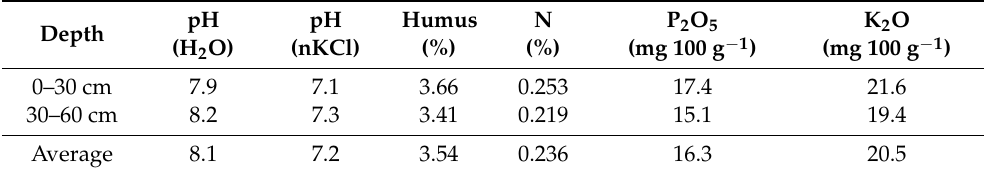
Table 3. Agrochemical analyses of soil (Surduk locality).